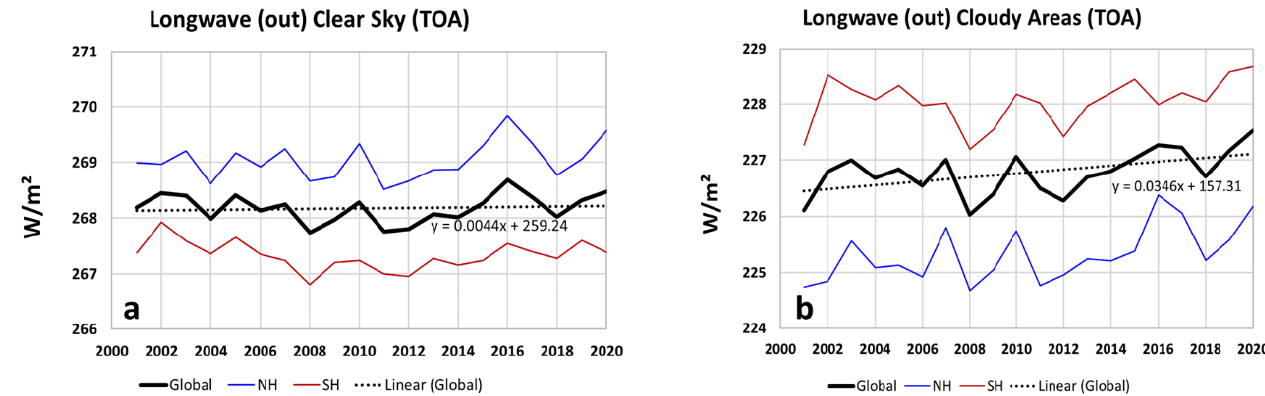
Figure 6. Outgoing longwave flux (TOA) over “Clear Sky” ( a ) and “Cloudy Areas” ( b ). The slope over the “Cloudy Areas” is eight times higher.